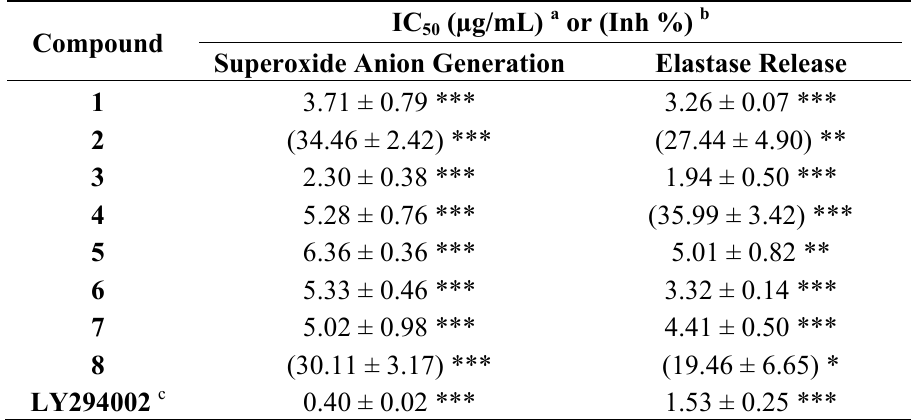
Table 1. Inhibitory effects of purified samples from G. mastoporum on superoxide anion generation and elastase release by human neutrophils in response to N -formyl- L